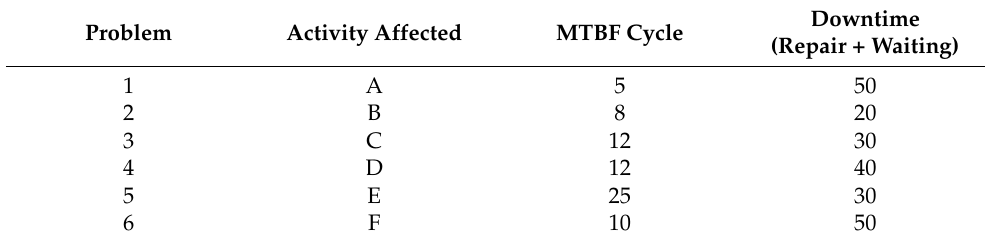
Table 5. List of the problems and reliability information.